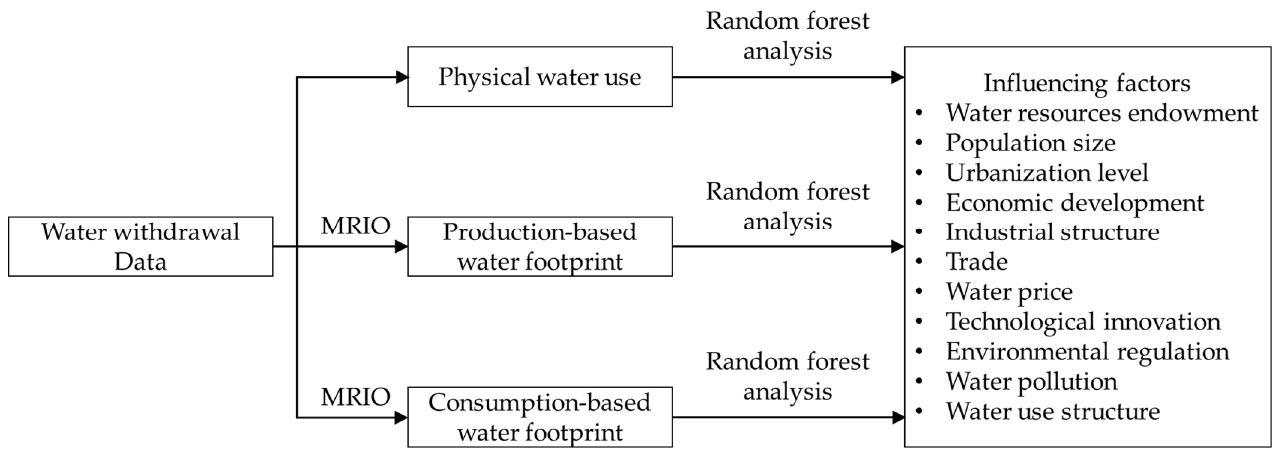
Figure 1. Flowchart of data processing.